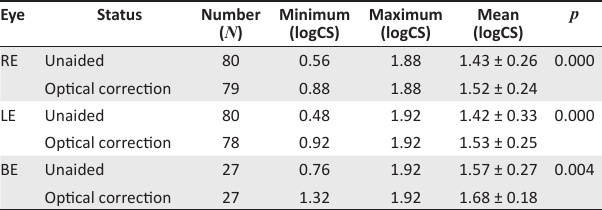
TABLE 4: Contrast sensitivity (logCS) without and with optical